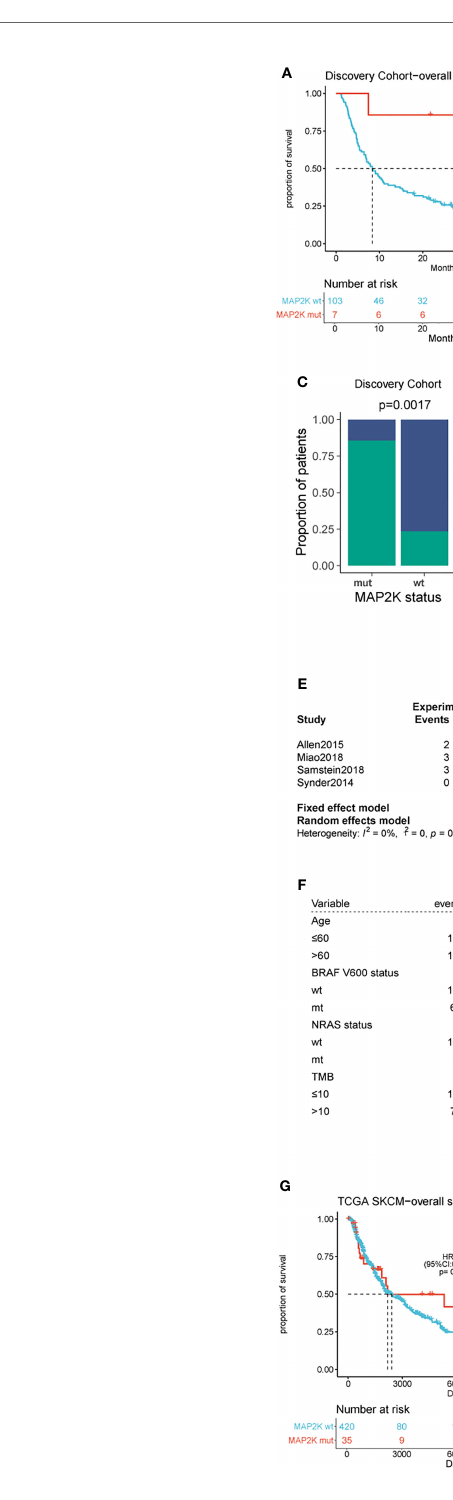
FIGURE 1 | Effect of MAP2K1/2 gene mutations on treatment response in anti-CTLA-4 and non-immunotherapy-treated melanoma. Kaplan-Meier analyses of overall survival (OS) (A) , progression-free survival (PFS) (B) , and disease-control rate (C) in the anti-CTLA-4-treated discovery cohort. Kaplan-Meier analyses of overall survival (OS) (D) in the anti-CTLA-4-treated validation cohort. Pooled estimates of OS in four anti-CTLA-4-treated cohorts (E) . Subgroup Cox analysis of OS in pooled anti-CTLA-4-treated cohorts among patients with and without MAP2K1/2 gene mutations (F) . Kaplan-Meier analyses of OS in TCGA melanoma cohort (G) and TCGA chemotherapy-treated cohort (H)